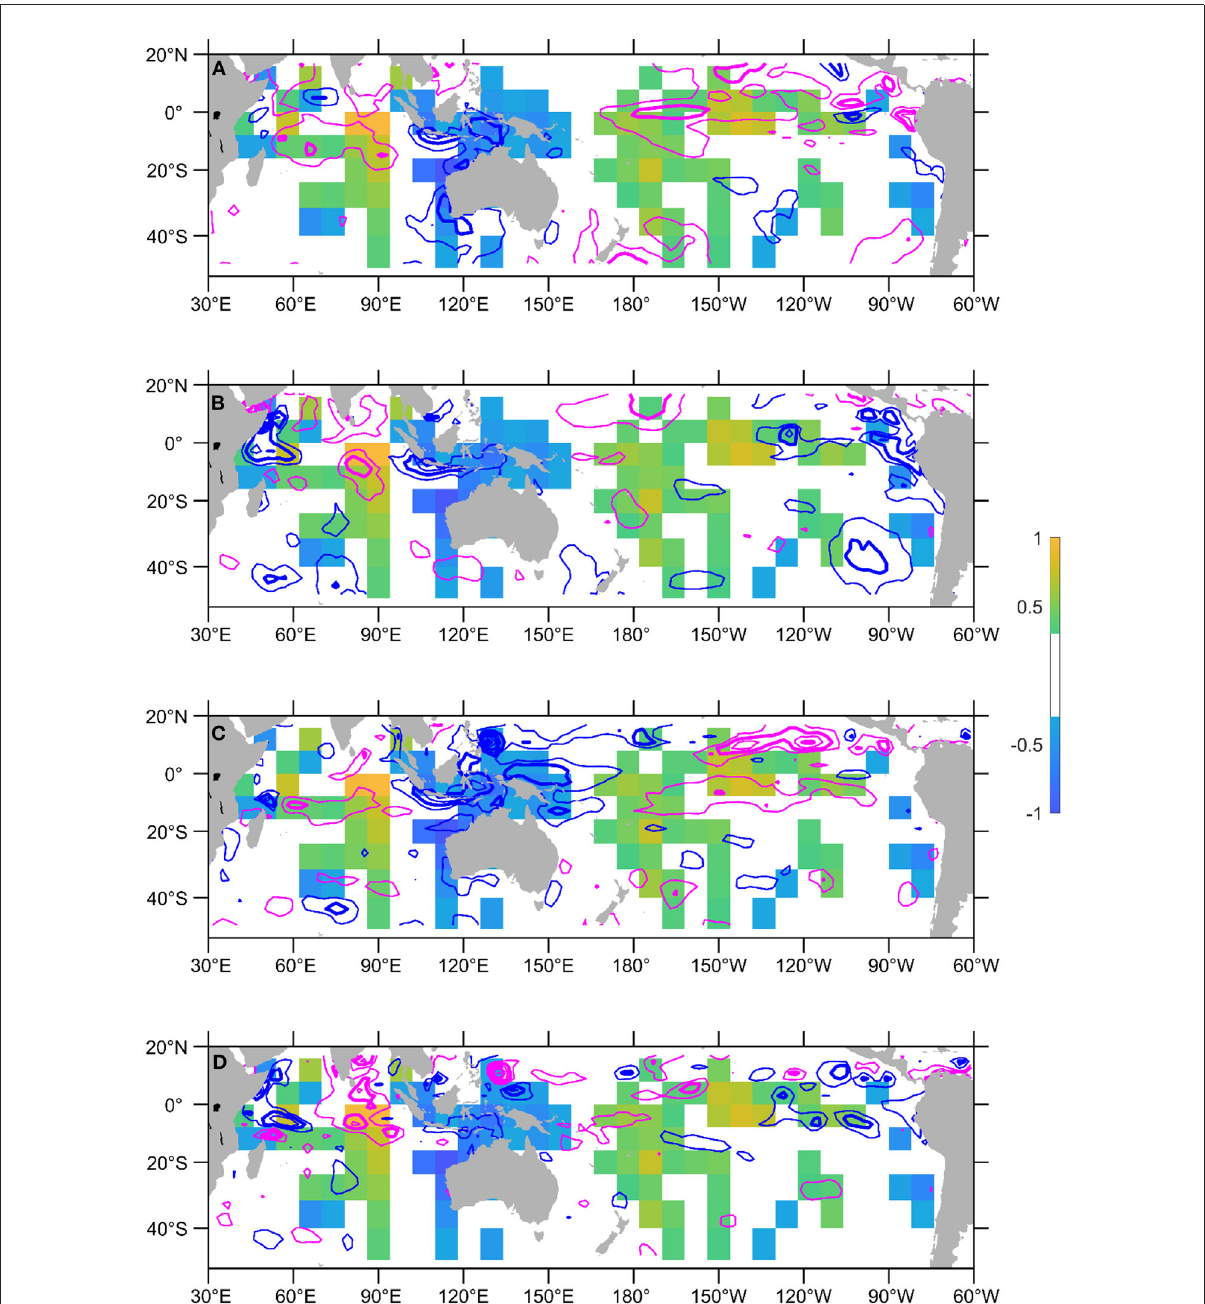
FIGURE7 Activation map of using June-July-August SST and heat content anomalies to forecast the October 2019 EIOD peak (only showing absolute values > 0.3). The activation map is overlaid with (A) SST anomalies in July 2019, (B) SST anomaly differences between August and June 1997, (C) heat content anomalies in July 2019, and (D) heat content anomaly differences between June and August 2019. Negative anomalies are denoted with blue contours and positive anomalies with magenta. Anomalies are plotted every 0.5 ◦ C, and the integer values are in bold contour. Zero contour lines are not